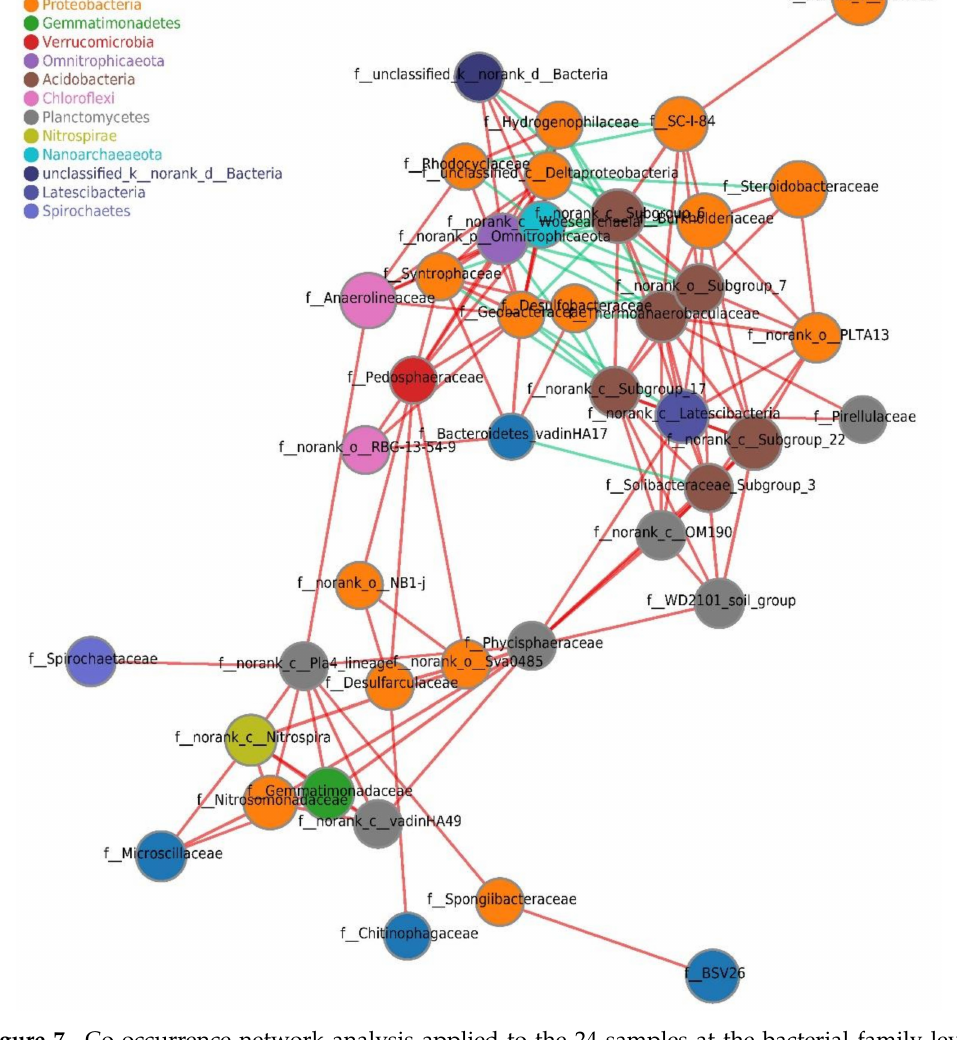
Figure 7. Co-occurrence network analysis applied to the 24 samples at the bacterial family level in Lake Chaohu. Co-occurring network colored by phylum. A connection represents a strong (Spearman’s p > 0.6) and significant (P < 0.05) correlation. The size of each node is proportional to the relative abundance; the thickness of each connection between two nodes (edge) is proportional to the value of Spearman’s correlation coe ffi cients. Red and cyan lines indicate positive and negative correlations,